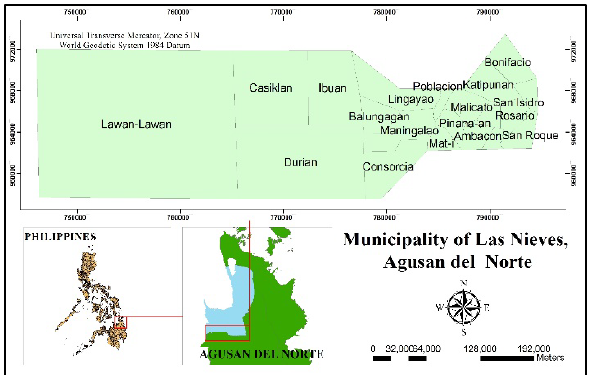
Figure 1. Map of the Study